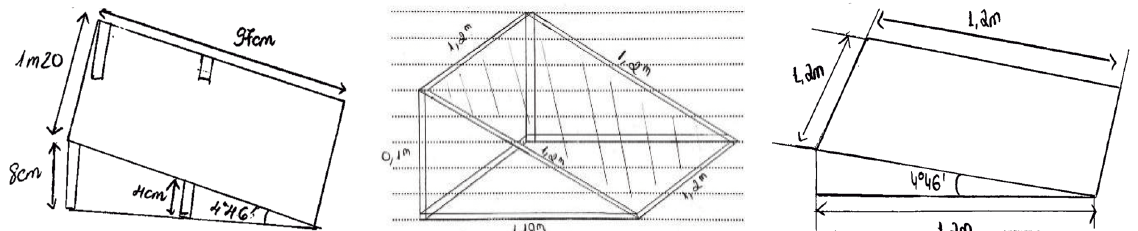
Figure 5a. Worksheet 3 of Groups. The design of the ramp